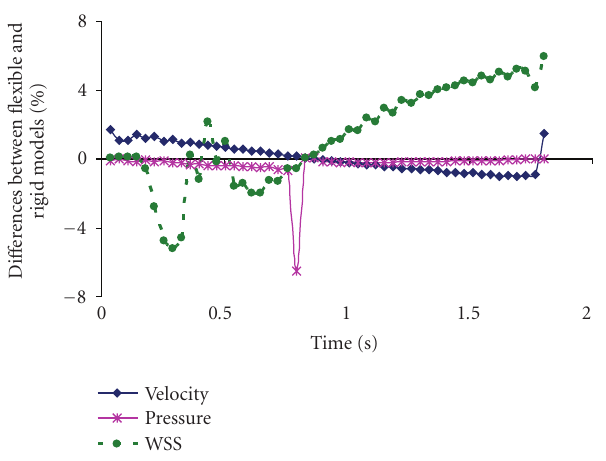
Figure 9: The tissue flexibility e ff ect on airflow velocity, airway pressure, and wall shear stress (WSS) during the inhalation.